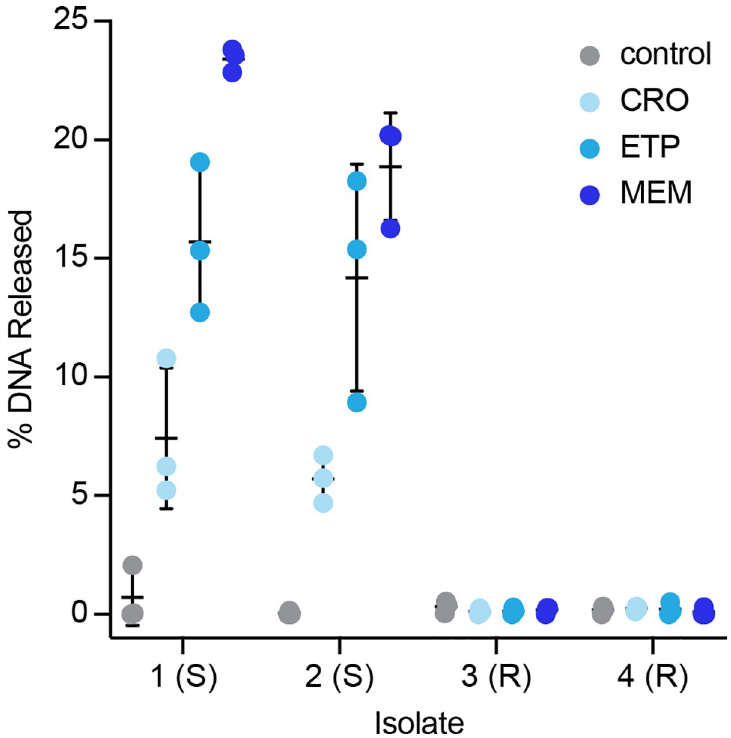
Fig 3. Percentage of DNA released following antibiotic exposure. Two susceptible and two resistant E . coli isolates were exposed to no antibiotic (control), CRO, ETP, or MEM for 15 min before filtering to separate intact cells from extracellular DNA. Experiments were performed in triplicate for all isolate/antibiotic combinations. Each point represents a single experiment; lines represent the average and standard deviation of replicate experiments. Raw data are provided in S6 Table. ABX, antibiotic; CRO, ceftriaxone; ETP, ertapenem; MEM, meropenem; R, resistant; S, susceptible.